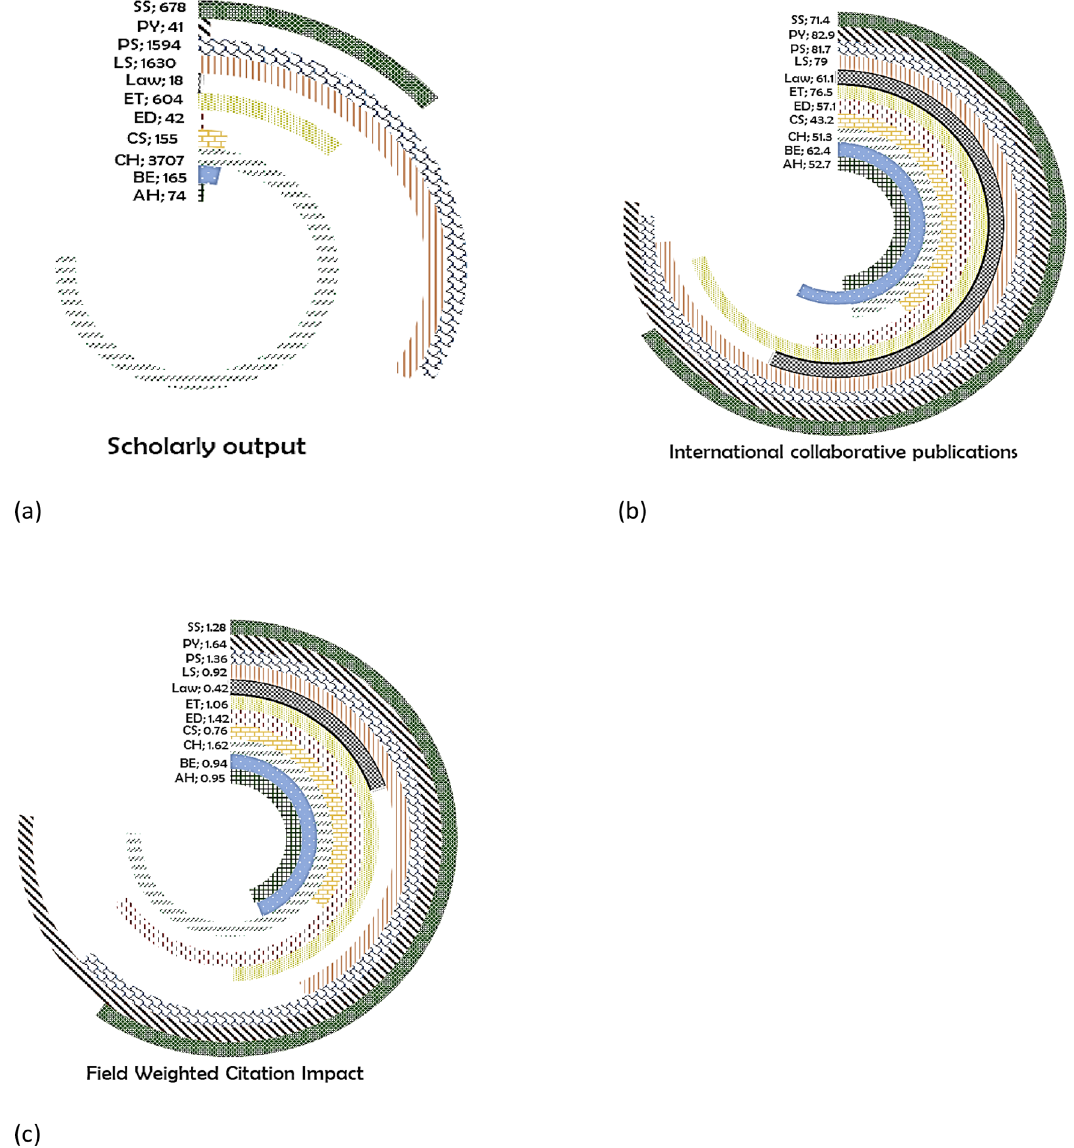
Figure 13. Subject wise split of Nepal research outcome (a) scholarly output, (b) International collaboration and (c) FWCI. Arts &Humanities (AH),Business and Economics (BE), Clinical, pre-clinical and health (CH), Computer Science (CS), Education (ED), Engineering and Technology (ET), Life Science (LS), Physical Science (PS), Psychology (PY), Social Science